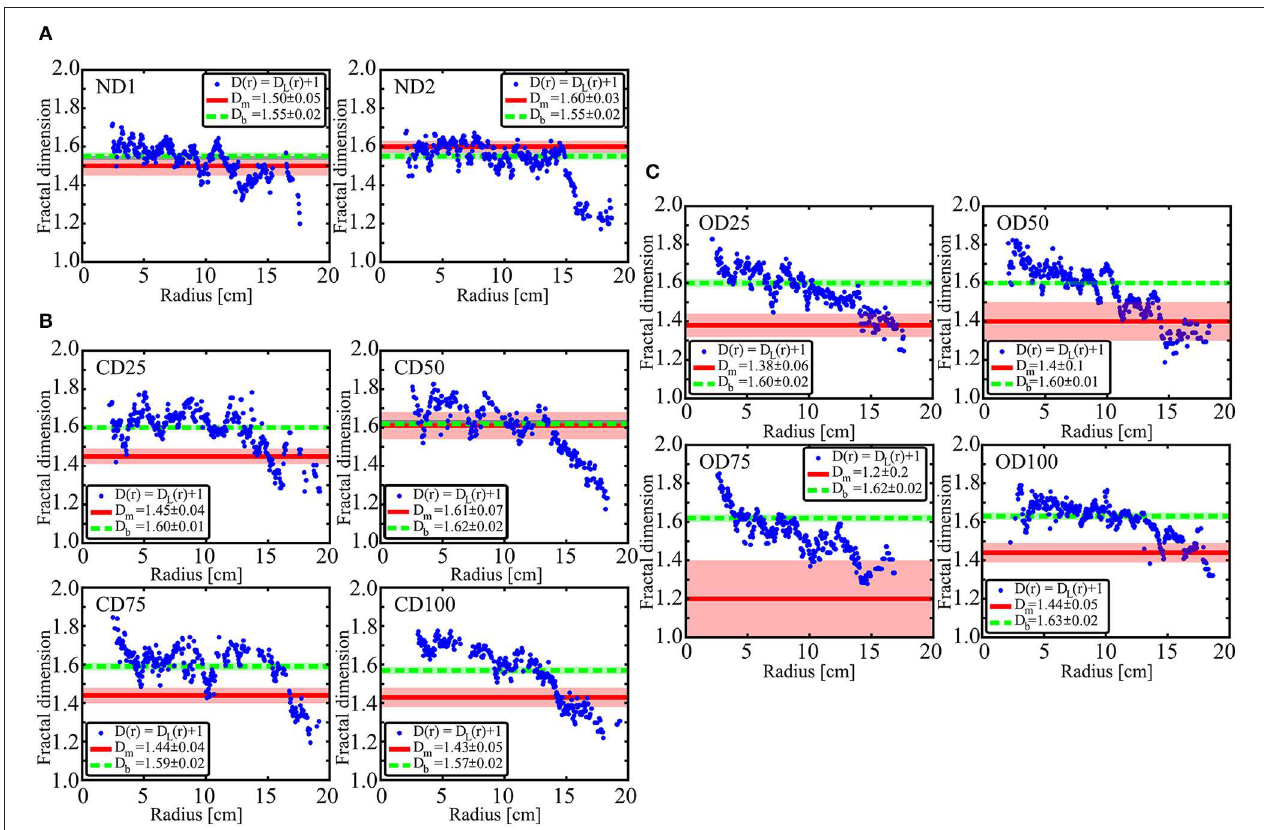
FIGURE 7 | The blue dots represent local fractal dimensions plotted as ( D L + 1) as function of radius for the non-deformable breakthrough patterns (A), confined deformable breakthrough patterns (B), and open deformable breakthrough patterns (C). The estimated mass dimensions D m are indicated as solid red lines with uncertainties shown as light red bands, and the box dimensions D b are indicated as dotted green lines with uncertainties shown as light green bands. Overlaps of the D m and D b uncertainties are colored gray. The injection pressure in both ND experiments is 25 hPa, while the number in the experiment names for the CD and OD experiments gives the injection pressure in hPa.